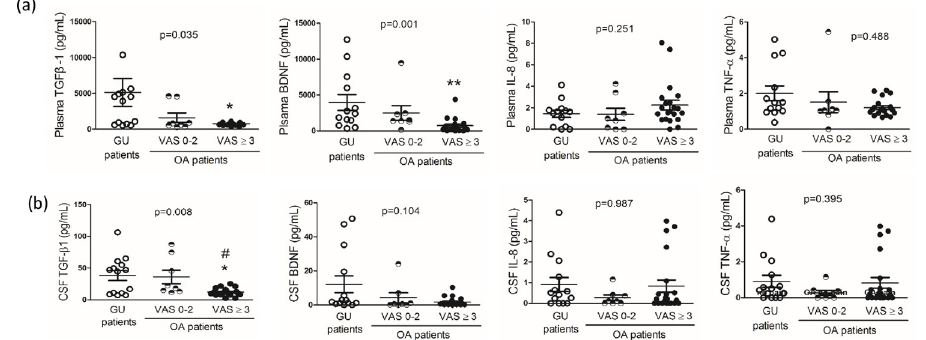
Fig 1. The levels of cytokines and BDNF in plasma and cerebral fluid (CSF) in patients with genitourinary examination or operation (GU, control) and patients with osteoarthritis (OA). OA patients were divided into very mild pain (Visual Analogue Scale, VAS score 0–2) and pain (VAS score � 3) groups according to their level of pain. The non-parametric method (Kruskal- Wallis test) was used to analyze the data. Data are mean ± SE. � p < 0.05, �� p < 0.01 vs. GU control patients. # p < 0.05 OA with very mild pain vs OA with pain.